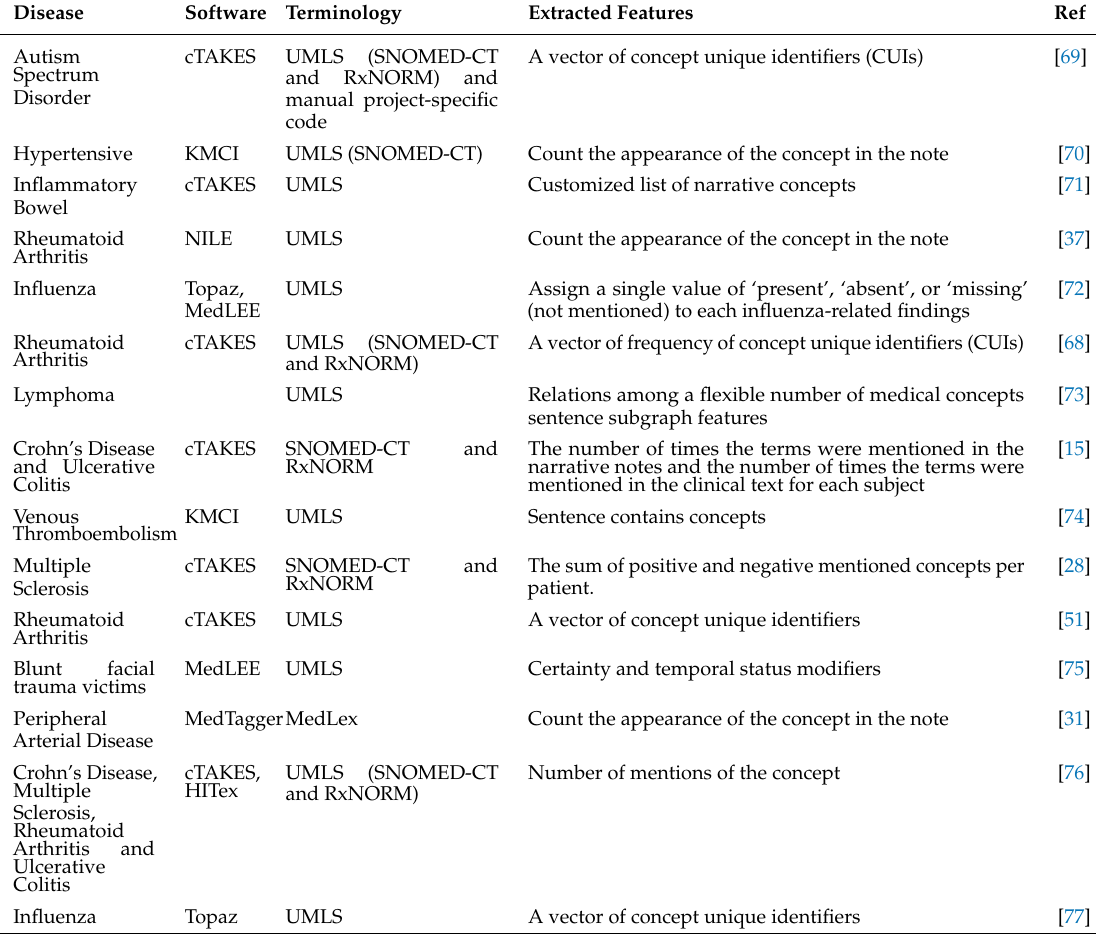
Table 1. Summary of studies using concept extraction